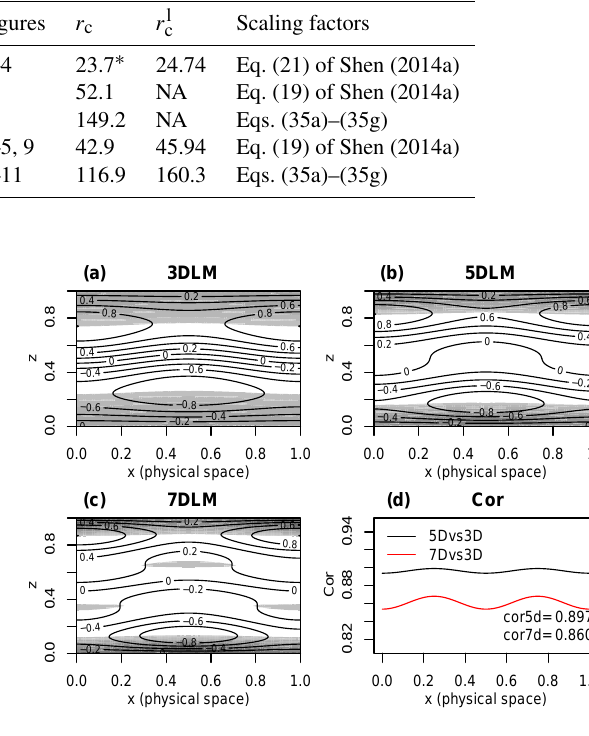
Figure 4. Temperature perturbation in the spatial space ( x , z ), rep- resented by the analytical solutions of critical points in the 3DLM, 5DLM, and 7DLM (a–c) . (d) Correlation coefficients, calculated for each x location using samples in the z